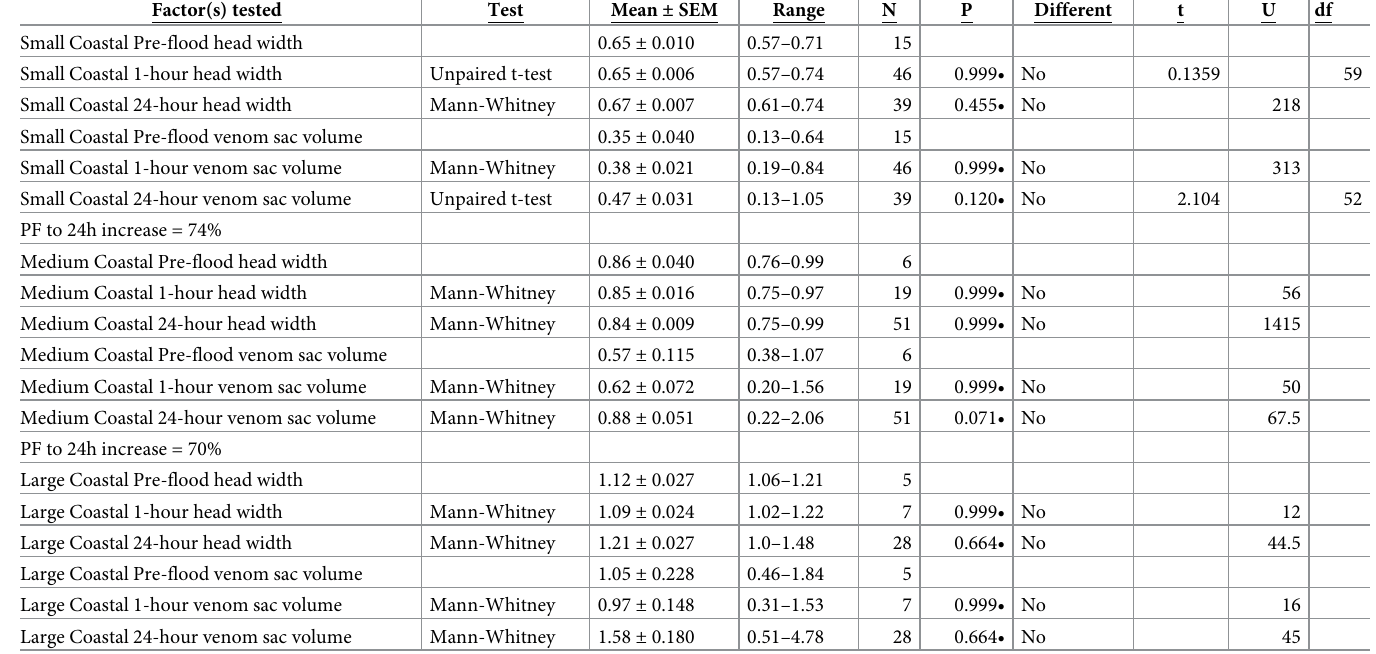
Table 1. Fire ant head width and venom sac volumes (calculated) and results of statistical analysis when grouped by size. Bonferroni corrections were applied to the p-values used in multiple comparisons to reduce the possibility of a Type-1 error. Those p-values which were corrected are noted with a • symbol. Corrected p-values were compared to the Bonferroni-corrected α critical =